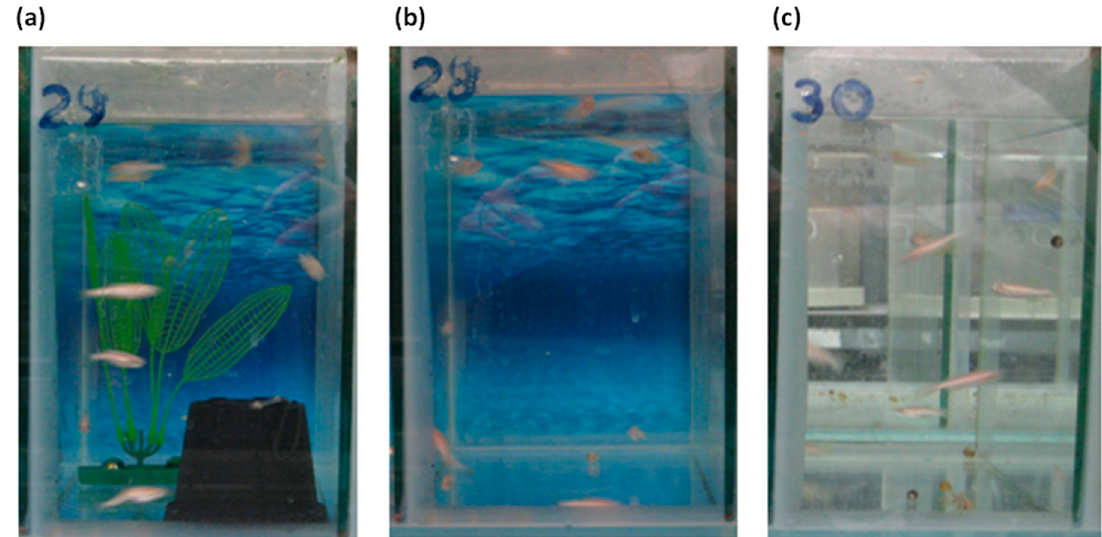
Figure 5. The three housing treatments: ( a ) very enhanced (VE), ( b ) mildly enhanced (ME), and ( c ) control (CT).